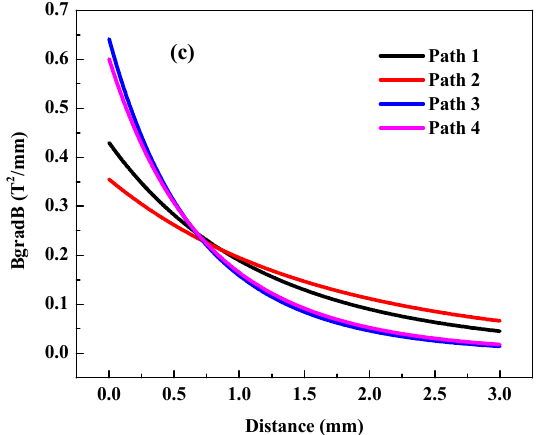
Figure 9. The data of magnetic parameters along the specified path. ( a ) The relationship between the magnetic field strength and the distance moving away from the matrix surface. ( b ) The relationship between the magnetic field gradient and the distance moving away from the matrix surface. ( c ) The relationship between the product of the magnetic field strength and the magnetic field gradient and the distance moving away from the matrix surface.